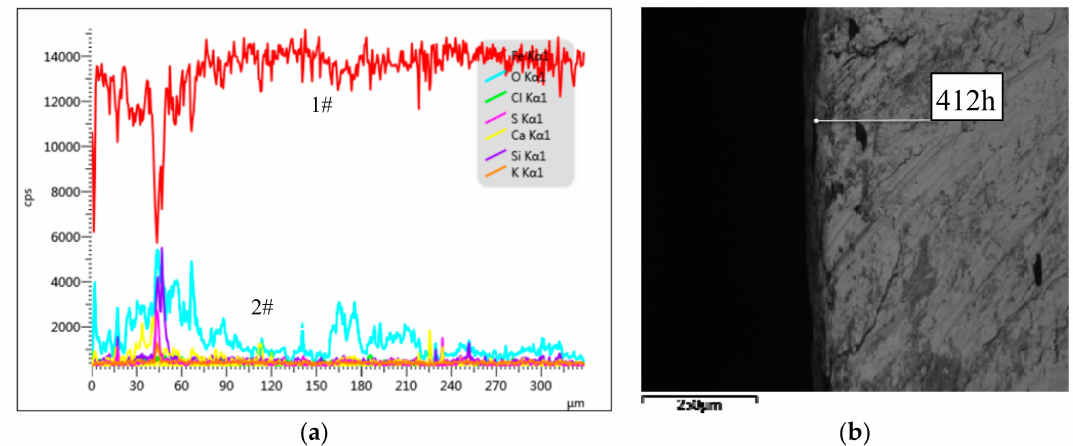
Figure 7. Group P line scan results. ( a ) The structure of steel corrosion products; ( b ) Micro-structure of corroded steel bars.